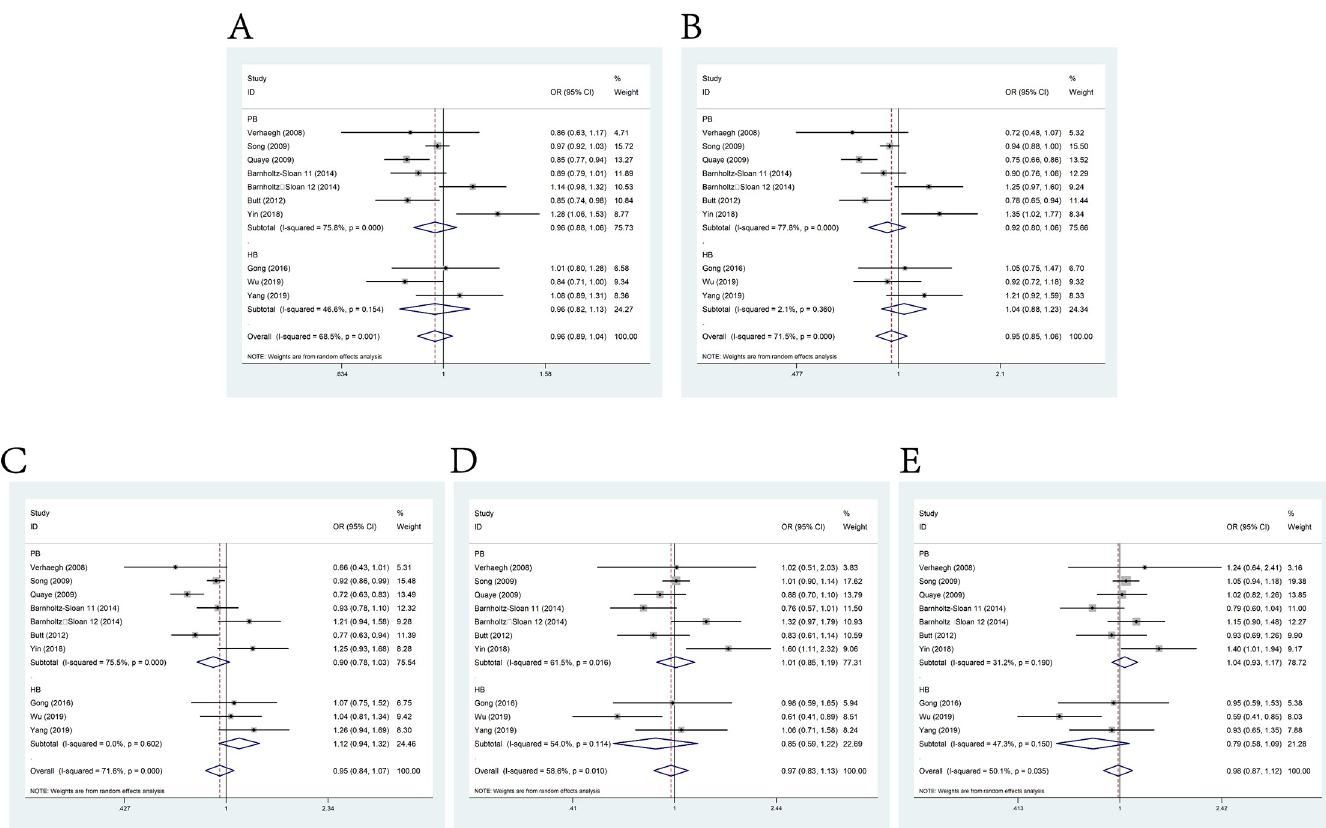
Fig 4. Forest plot of the association between H19 polymorphism rs2107425 C > T and cancer susceptibility. A: allele model; B: dominant model; C: heterozygote model; D: homozygote model; E: recessive